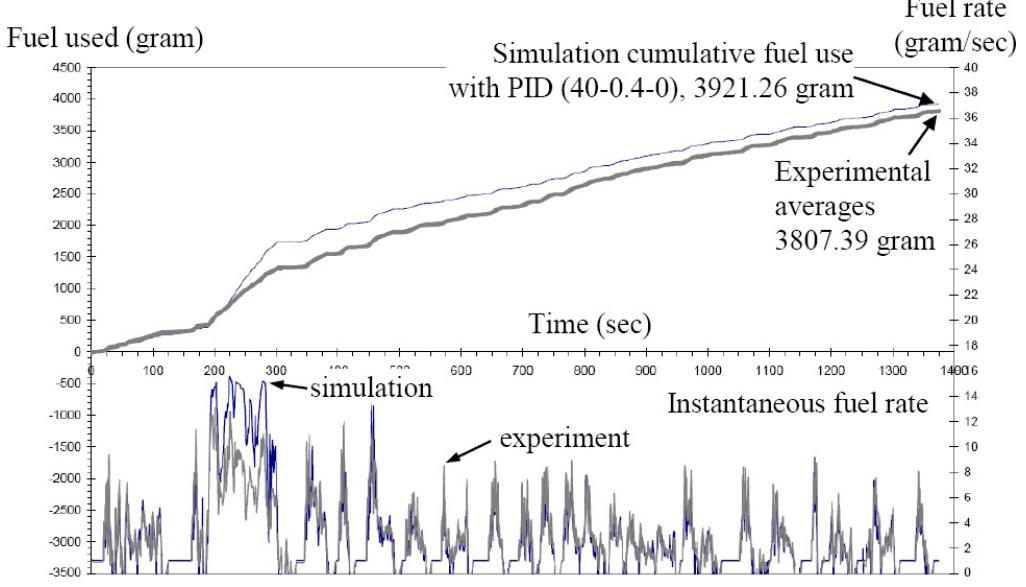
Figure 7. Comparison of simulated fuel consumption with experimental data–baseline vehicle.